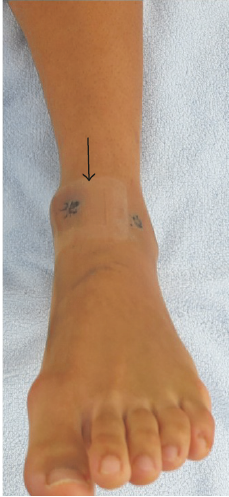
Figure 4: Photograph of the ankle and foot showing swelling betweentheanteromedialportalandtheanterolateralportal(arrow) 3 days after ankle